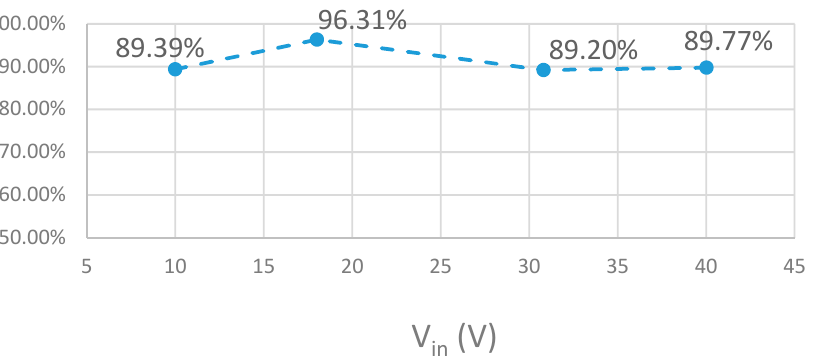
Figure 22. E ffi ciency performance of the proposed Figure 22. Efficiency performance of the proposed converter.